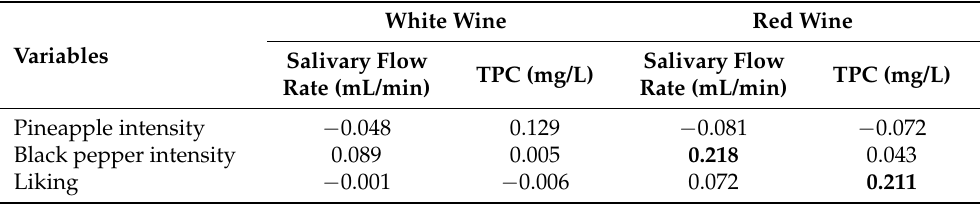
Table 5. Pearson correlation coefficients between salivary parameters (salivary flow rate and total protein content), retronasal aroma intensity perception (pineapple and black pepper) and liking in both wines (white and red